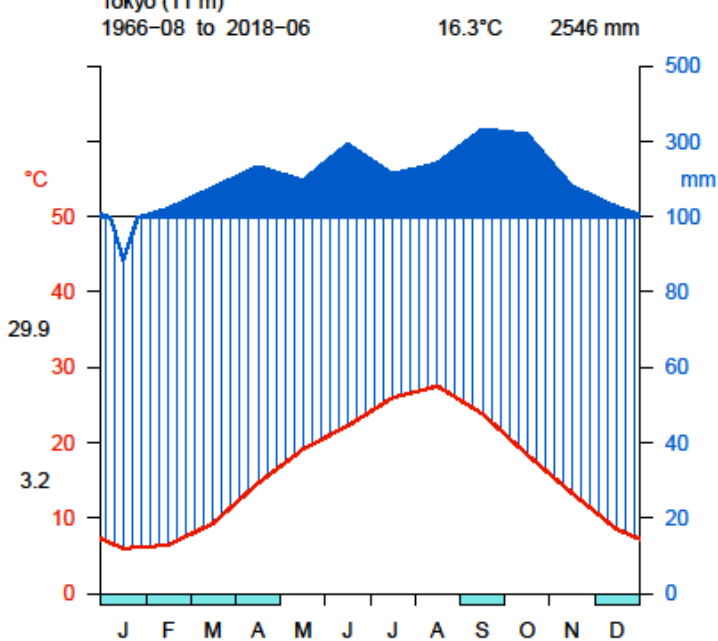
Figure 1. ‘Walter and Lieth’ diagram [11] for Tokyo City showing averages for air temperature (Ta, left axis, shown in red) and average sum of monthly precipitation (right axis, provided in blue) in the period from August 1966 to June 2018. Humid conditions (average monthly sum of precipitation exceeds 0.5 times the average Ta) are shown by blue lines (blue polygons if 300 mm are exceeded). Table 1. Overview table showing statistics for the meteorological parameters air temperature, relative humidity, vapor pressure, wind velocity (in 10.0 m above ground level) and cloud cover recorded at Tokyo covering the period 22 August 1966 to 1 June 2018 in 3 h temporal resolution.